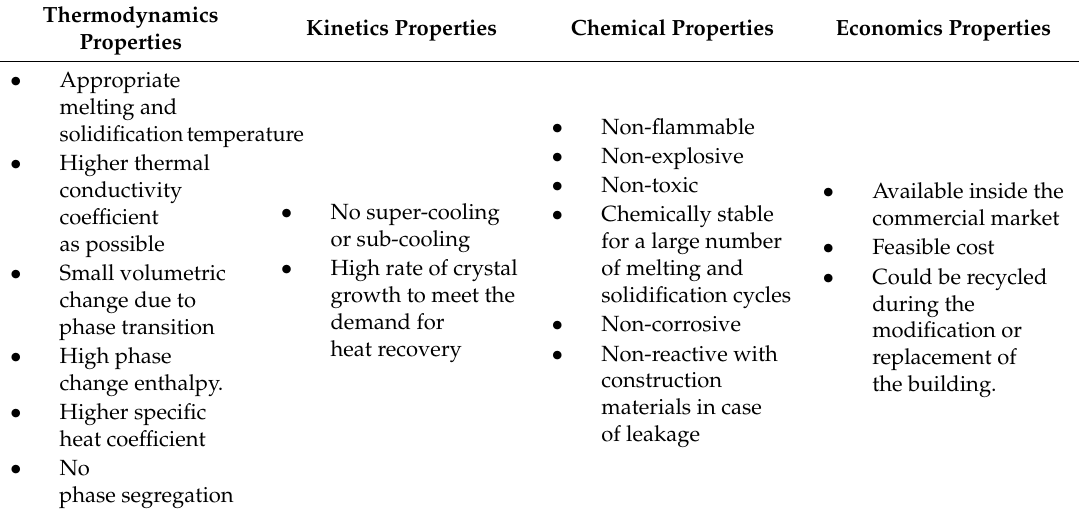
Table 2. Selection criteria for PCM in building